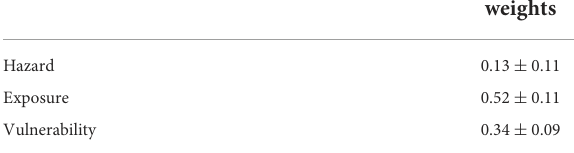
TABLE 3 Normalized weight of indicators for the hazard, exposure, and vulnerability components obtained from the AHP procedure and their corresponding uncertainty.